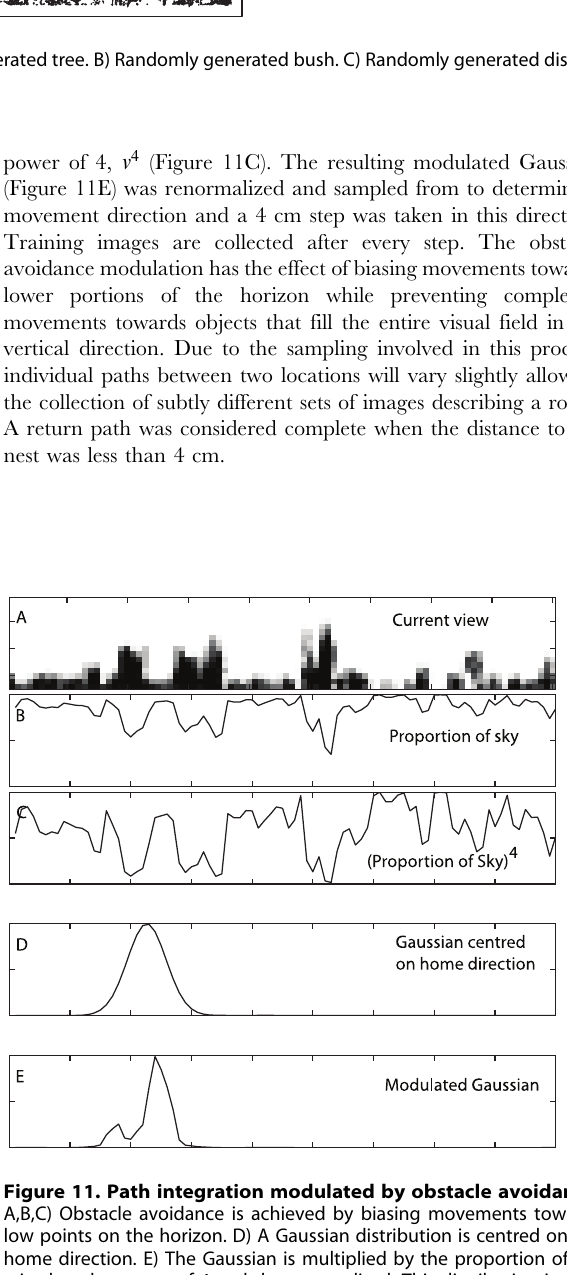
Figure 11. Path integration modulated by obstacle avoidance. A,B,C) Obstacle avoidance is achieved by biasing movements towards low points on the horizon. D) A Gaussian distribution is centred on the home direction. E) The Gaussian is multiplied by the proportion of sky raised to the power of 4 and then normalised. This distribution is then sampled from to determine a movement direction.